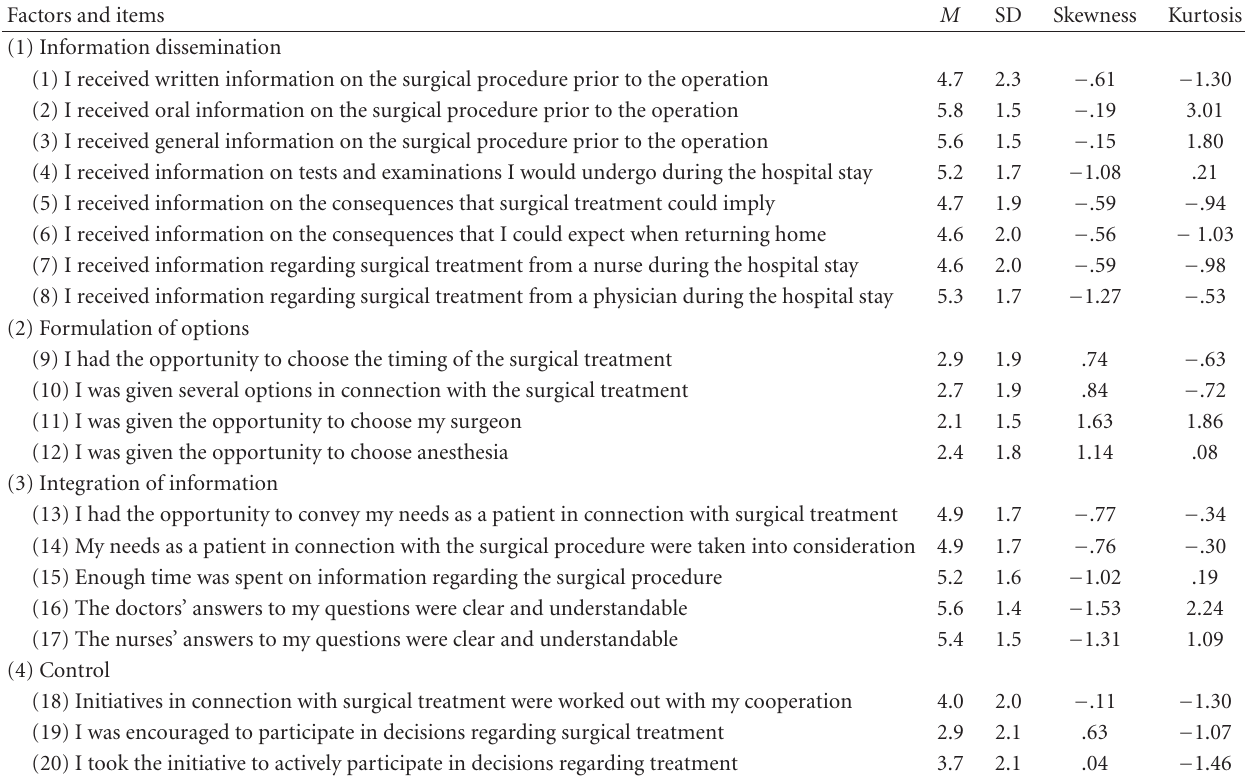
Table 3: Distribution of items.